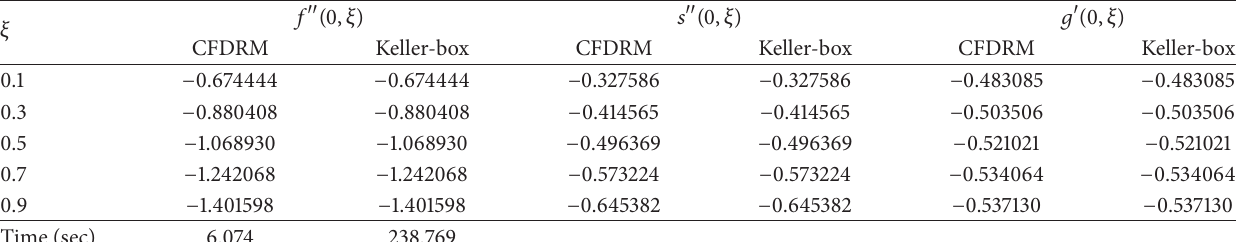
Table 2: CFDRM and Keller-box results for 𝑓 󸀠󸀠 (0,𝜉), 𝑠 󸀠󸀠 (0,𝜉) , and 𝑔 󸀠 (0,𝜉) in Example 2 when 𝑀 = 1 , 𝑐 = 0.5 , and Pr = 0.7. 𝑓 󸀠󸀠 (0, 𝜉) 𝜉